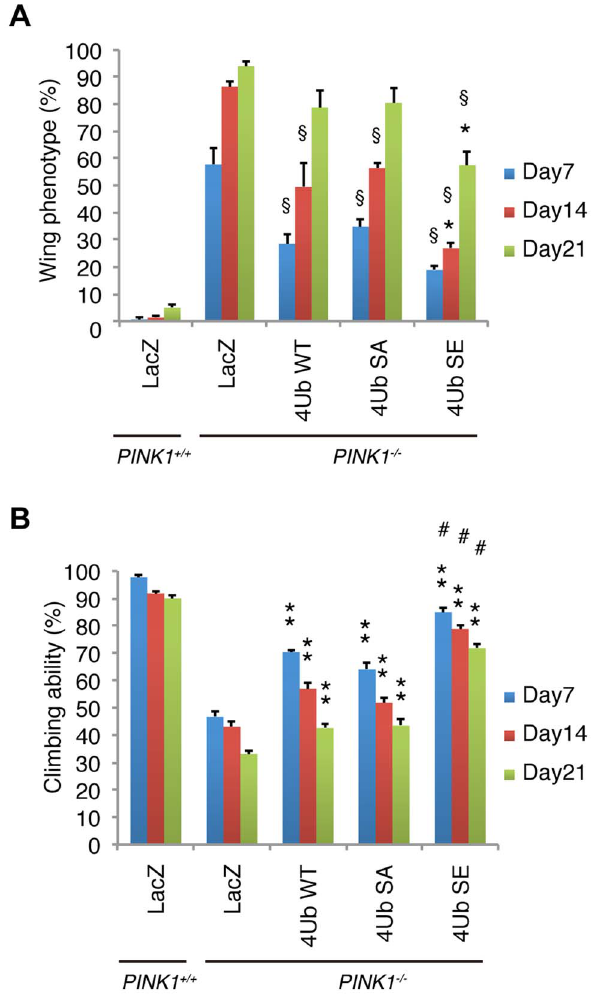
Figure 8. Mitochondrial phospho-mimetic polyUb chain impro- Drosophila . ( A ) The mitochondrial expression of 4xUb (WT, SA and SE) rescues the abnormal wing posture caused by the loss of PINK1 activity ( 1 p , 0.01, LacZ vs. WT, SA or SE in PINK1 2 / 2 at the same age), and 4xUb SE exerted a more profound effect (* p , 0.05, SE vs. WT or SA in PINK1 2 / 2 at the same age). LacZ or Tom70 MTS -2FLAG-4xUb (WT, SA or SE) was expressed under the control of MHC-GAL4 in the w- or the PINK1 2 / 2 backgrounds. LacZ served as a control. Graph showing the percentage of flies with abnormal wing posture. Adult male flies aged 7, 14 and 21 days were analyzed. n =159– 168. ( B ) The mitochondrial expression of 4xUb (WT, SA and SE) improved the motor activity throughout the trials (** p , 0.01, LacZ vs. WT, SA or SE in PINK1 2 / 2 at the same age), whereas 4xUb SE showed the best motor activity in every trial ( # p , 0.01, SE vs. WT or SA in PINK1 2 / 2 at the same age). The values are presented as the mean 6 SEM of 20 trials. Male flies were used for the